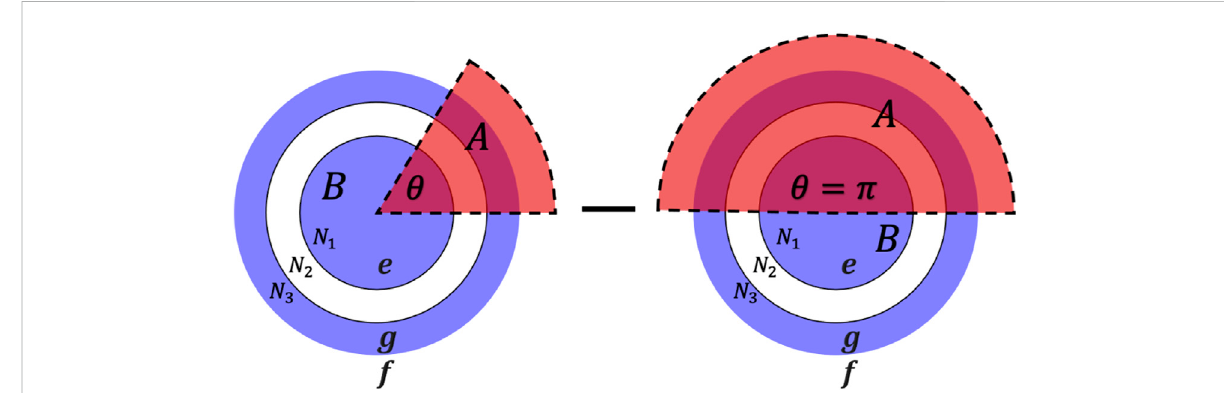
FIGURE 10 Non-smooth cutting schematic diagram of a disk that occurs in edge reconstruction. The system contains two unconnected parts containing N N 1 electrons in bulk and 3 electrons in the edge, respectively, and they are separated by edge of the reconstructed stripe has opposite chirality to that of the other two edges. By the same subtraction rule, we extract pure angle contribution and edge contribution.